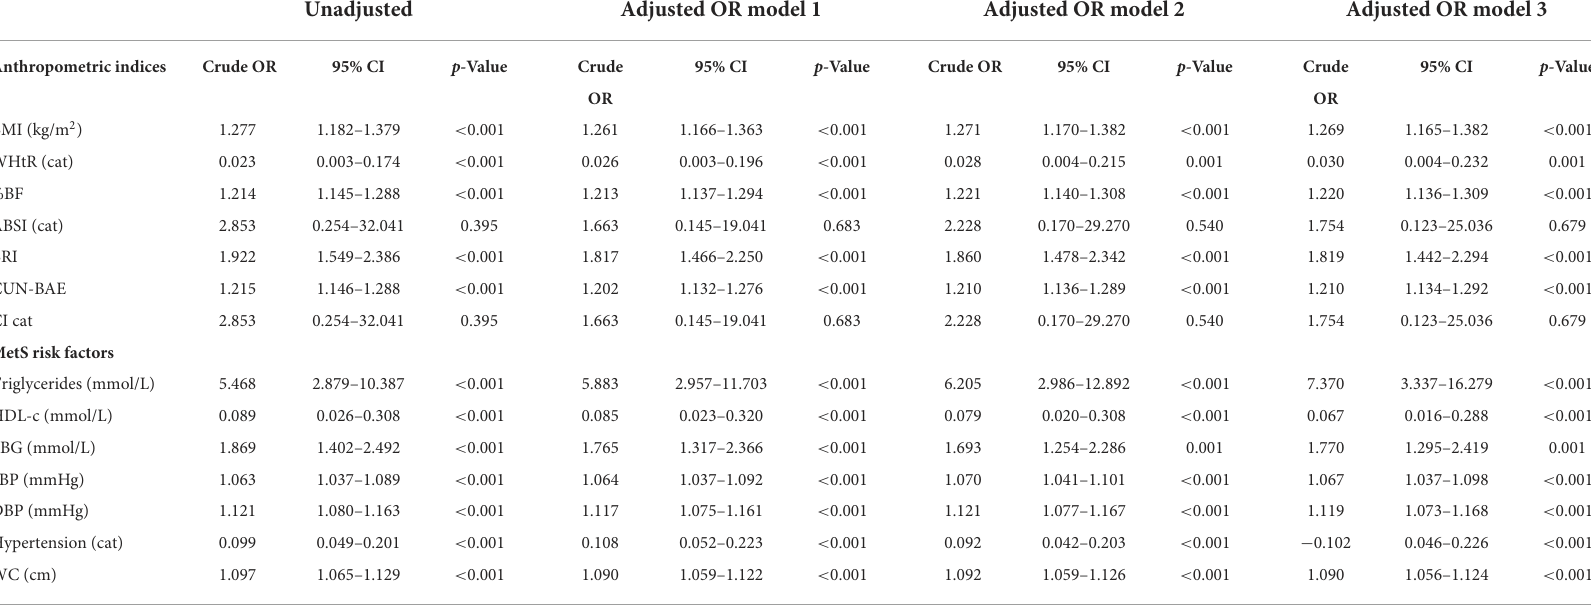
TABLE 6 The risk for metabolic syndrome among South African males aged 20 years and older by anthropometric